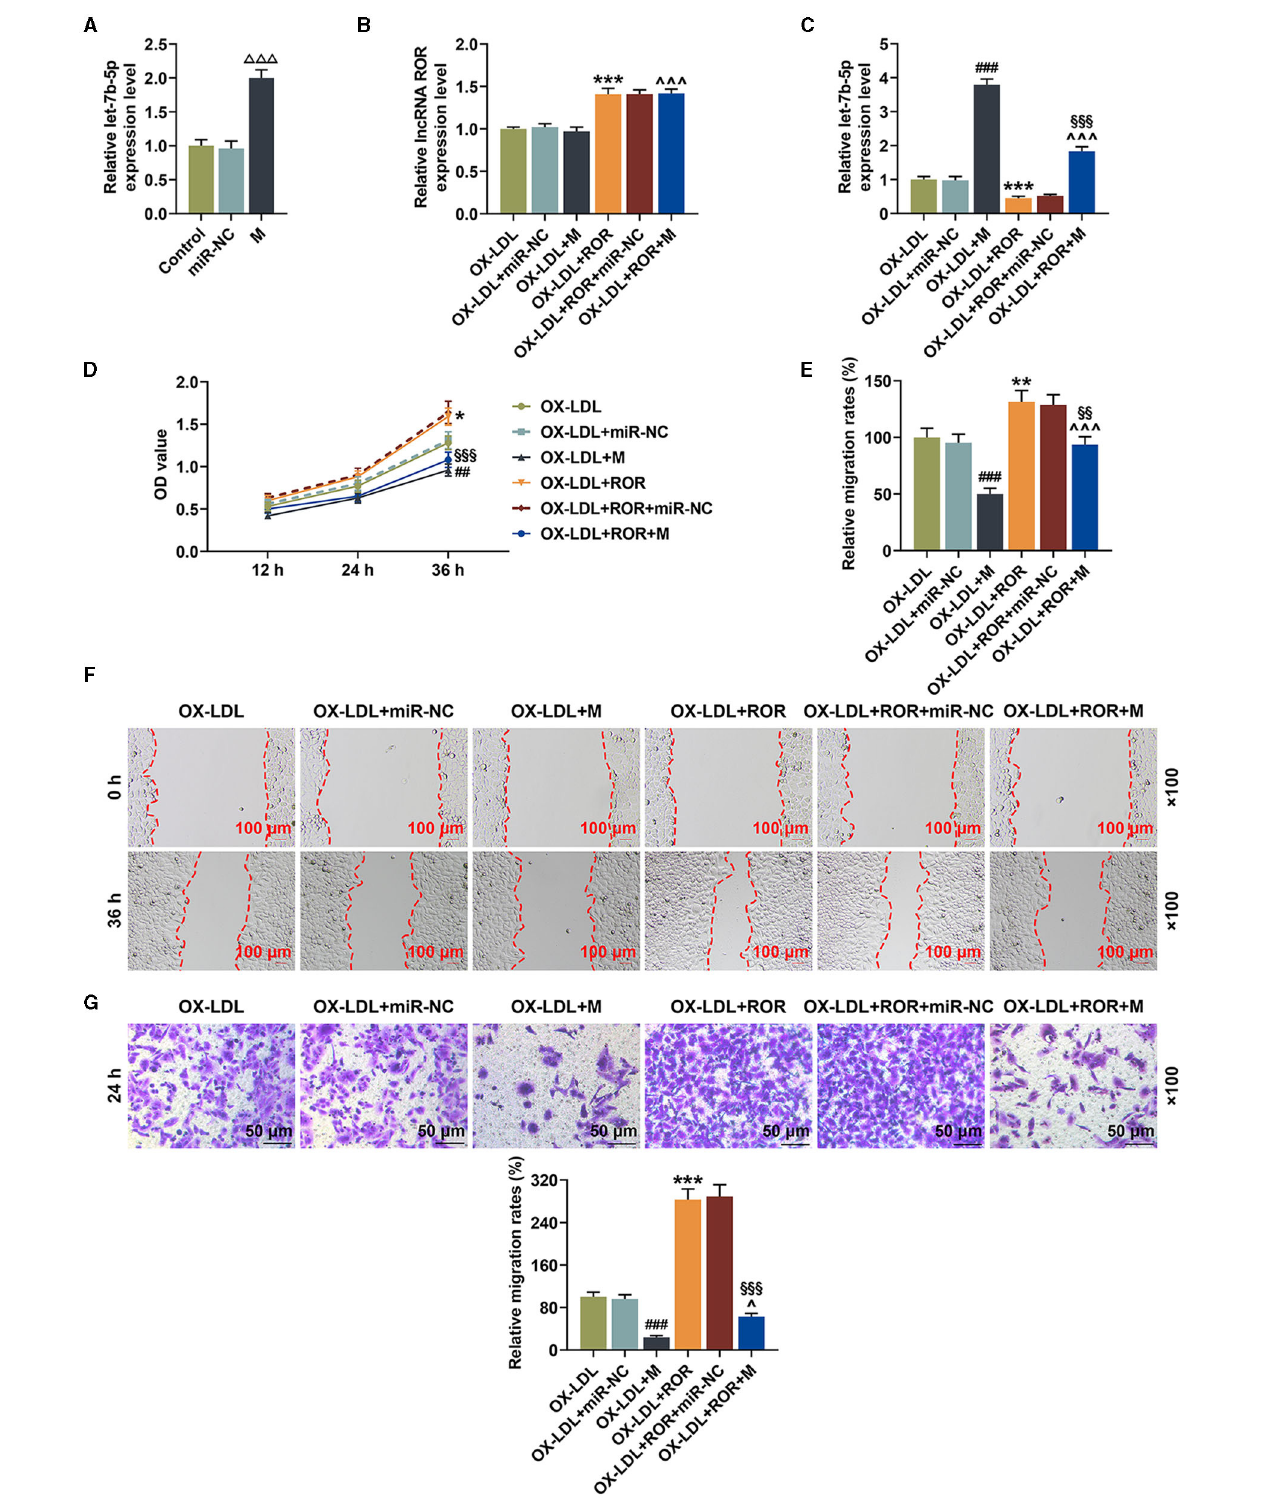
FIGURE 3 | let-7b-5p reversed the effects of upregulated lncRNA regulator of reprogramming (ROR) expression on let-7b-5p expression as well as the cell viability andmigrationofox-LDL-treatedhumanumbilicalveinendothelialcells(HUVECs). (A)